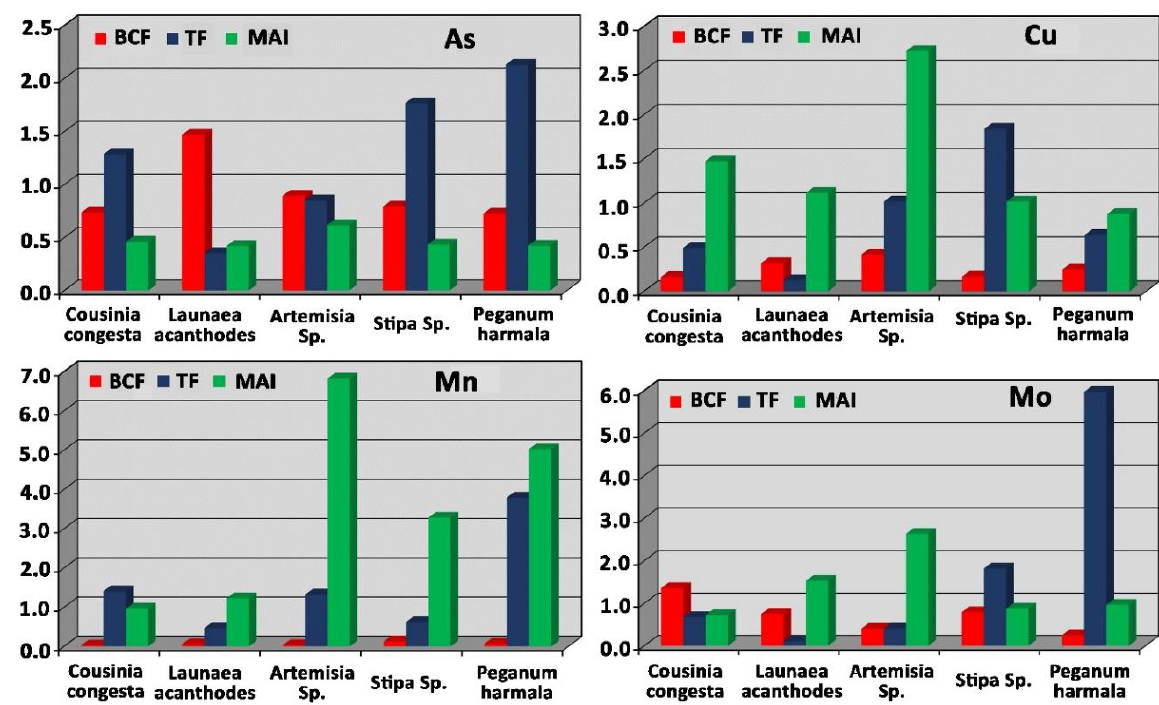
Figure 6. The BCF, TF, and MAI factors for Mn, Mo, Cu, and As in the native plant